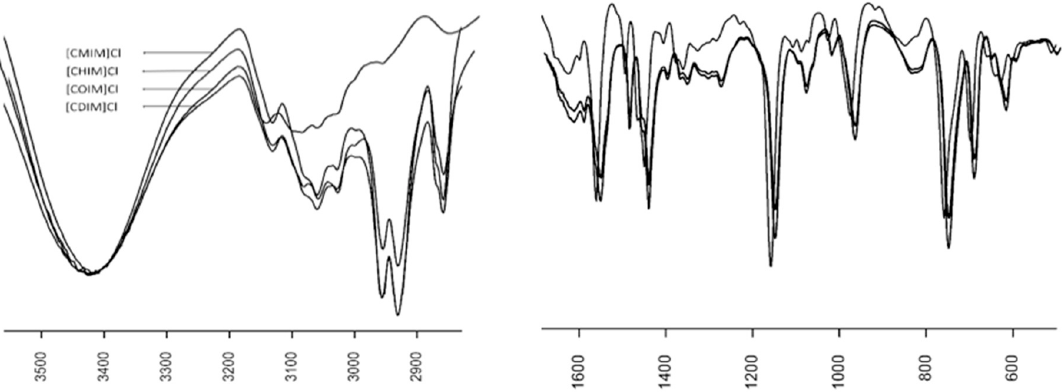
Figure 1. IR spectra of the different N -cinnamylimidazolium ILs.